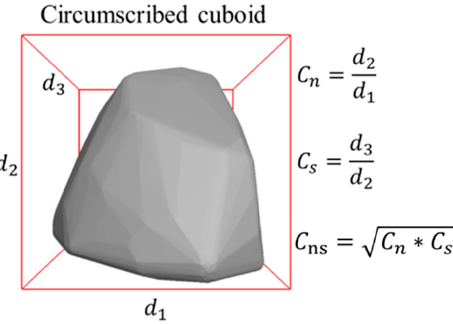
Figure 5. The diagram defining typical particle shape indices C n , C s , and C ns .